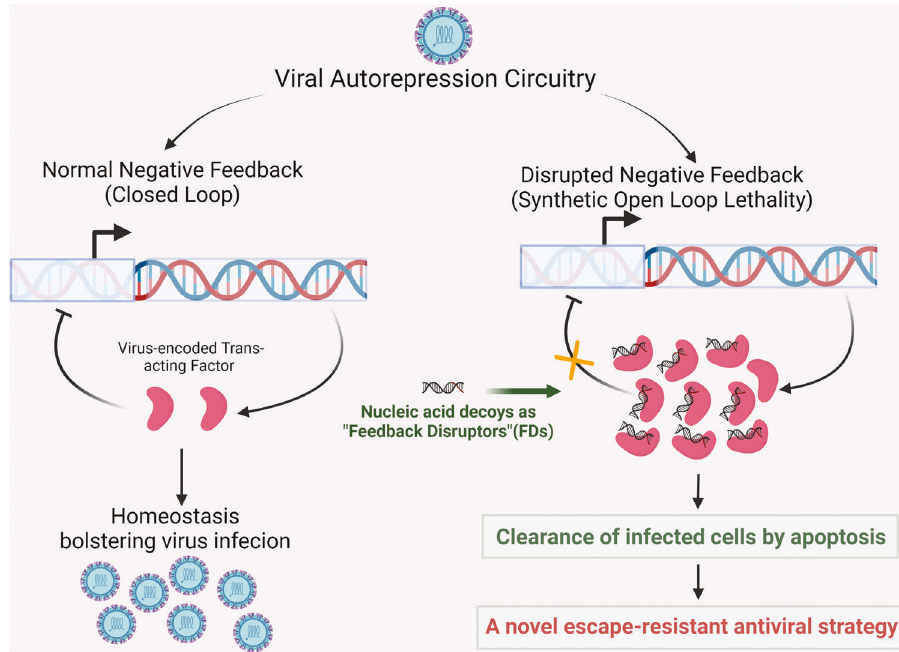
Fig. 1 Synthetic “ open-loop lethality ” makes autorepression circuitry the viral Achilles ’ heel. Virus-encoded speci fi c protein can serve as trans - acting factor that binds to the cis- repression sequence on viral genome and auto-represses viral transcription to avoid aberrant viral protein expression, thus maintaining homeostasis bene fi cial for virus infection (left). Arti fi cially synthesized nucleic acid decoys (molecular mimics of the cis -regulatory binding sites) can disrupt the normal negative feedback, raising viral protein expression to cytotoxic levels and leading to clearance of infected cells by apoptosis (right). This synthetic “ open-loop lethality ” turns the viral autorepression circuitry into a fatal weakness of virus life cycle, representing a novel and escape-resistant antiviral